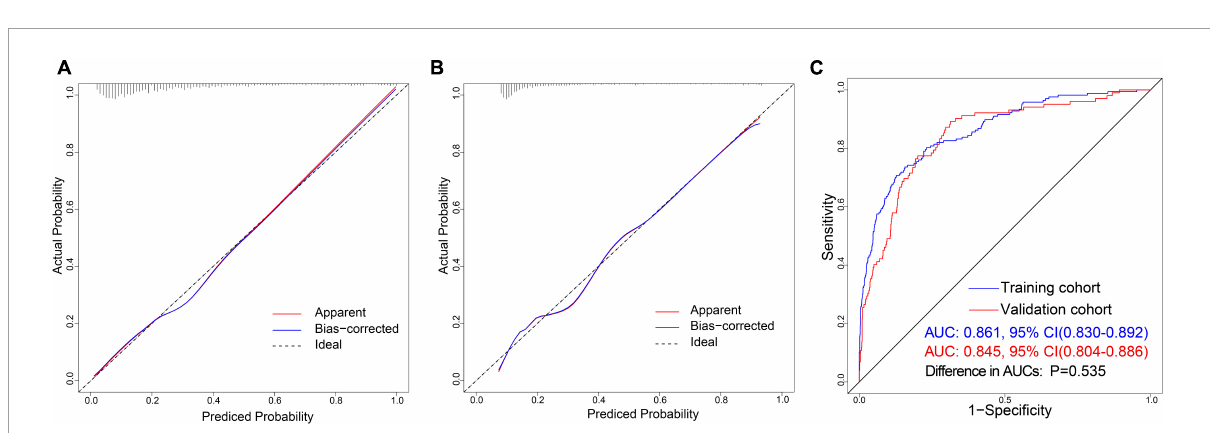
FIGURE5 Discrimination and calibration of nomogram prediction models in the training and validation cohorts. (A) Calibration plot in the training cohort. (B) Calibration plot in the validation cohort. (C) ROC curves in both the training and validation